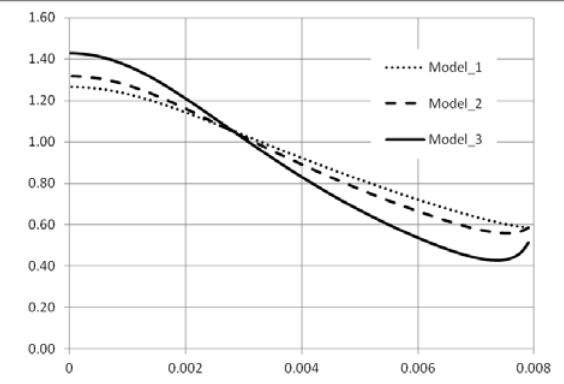
Figure 5. Normalized profiles of the total growth rates: points — model 1, dotted — model 2, solid — model